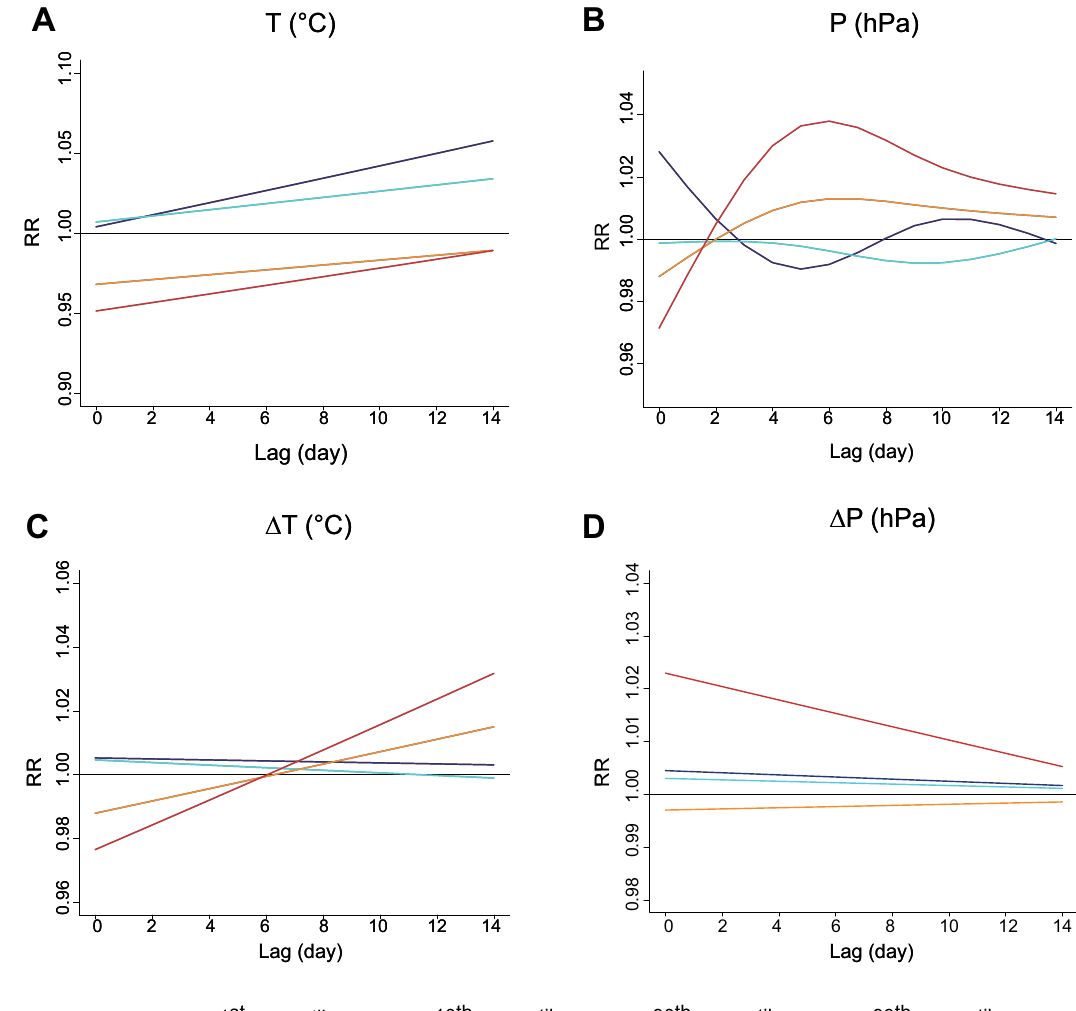
Figure 3. Global DLNM (only significant results are reported). Lag-specific effect on CD events for increases of each of the meteorological variables temperature (A) , pressure (B) , temperature amplitude (C) and pressure amplitude (D) , over the thresholds indicated in the legend in the plot for all zones in Région